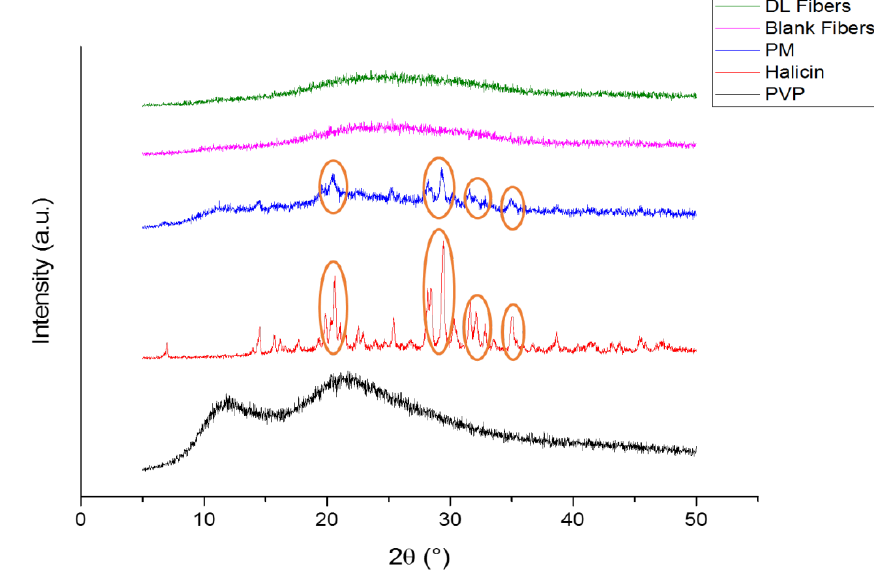
Figure 4. X-ray diffraction (XRD) patterns of PVP, halicin, PM, blank and drug-loaded fibers showing